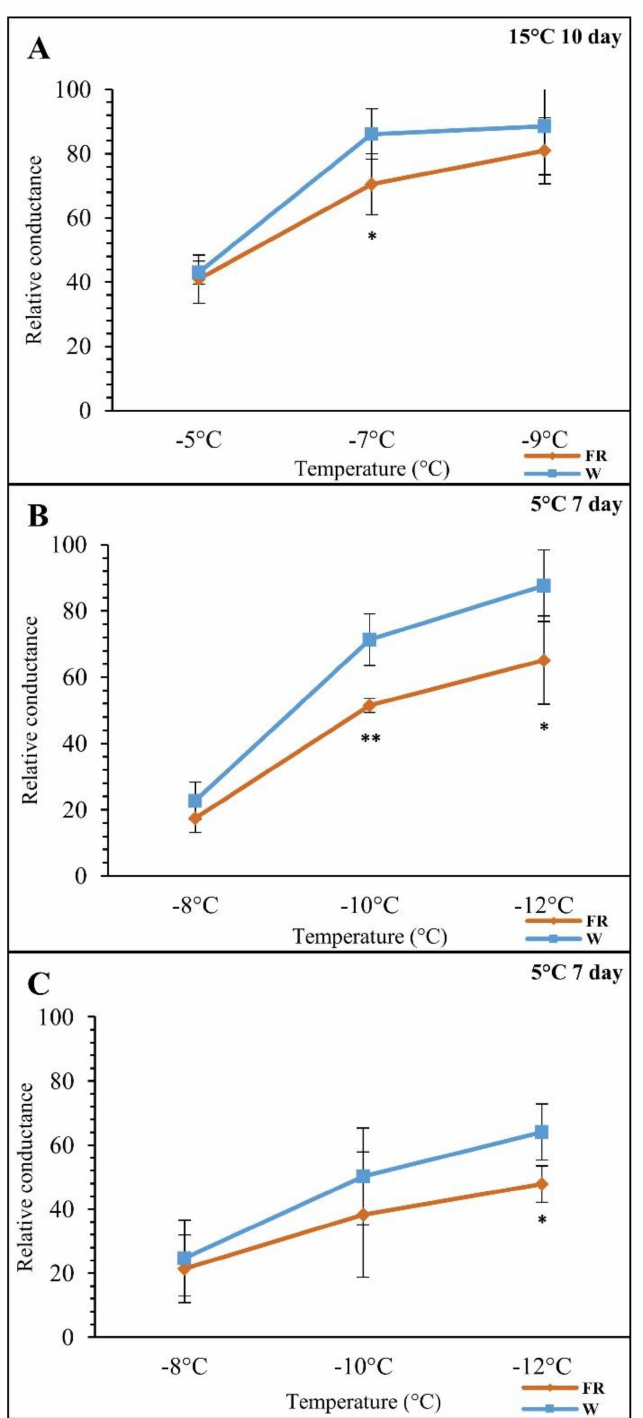
Figure 2. The effects of the supplementary far-red light treatments (FR) on plants’ freezing tolerance determined on the basis of electrolyte leakage. The relative conductance values correspond to percentage of lethality. ( A ) (FR-M): FR treatment at 15 ◦ C for 10 days (treatment began on day 18). ( B ) (FR-M/FR-C(28)): FR pre-treatment at 15 ◦ C for 10 days followed by cold stress at 5 ◦ C for 7 days (cold treatment began on day 28). ( C ) (FR-C(18)): Combined cold (5 ◦ C) and FR treatment for 7 days (treatment began on day 18). W: white light; FR: far-red-enriched light. The data are mean values from five biological replicates. Significance of difference between the control W, and the FR treated samples is designated as * p < 0.05 and ** p < 0.01 with Student’s t